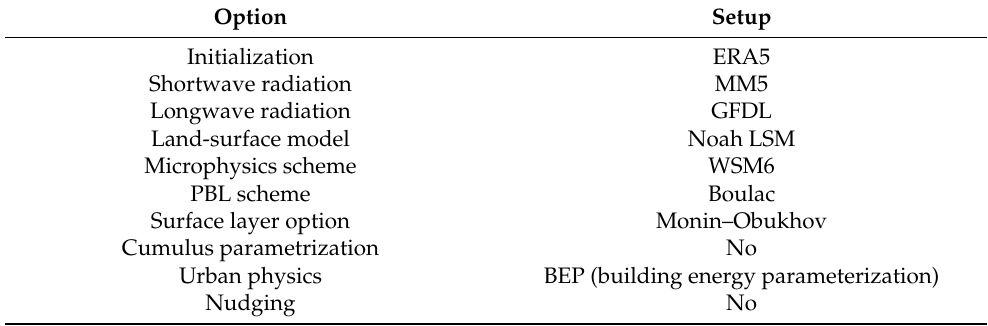
Table 1. WRF model